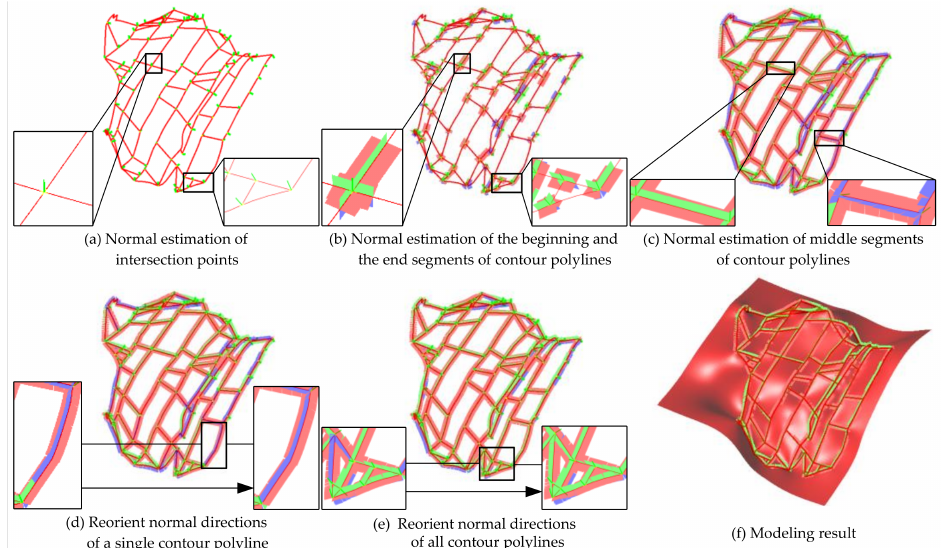
Figure 11. Experimental results of the third set of cross-contour polylines. ( a – c ) show the process of the normal estimation; ( d , e ) show the process of the reorienting normal directions; ( f ) shows the final modeling